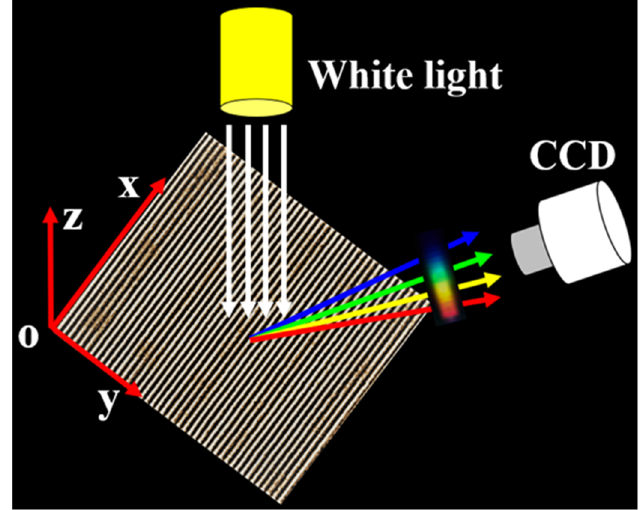
Figure 2. Schematic of the setup for structural color measurement.